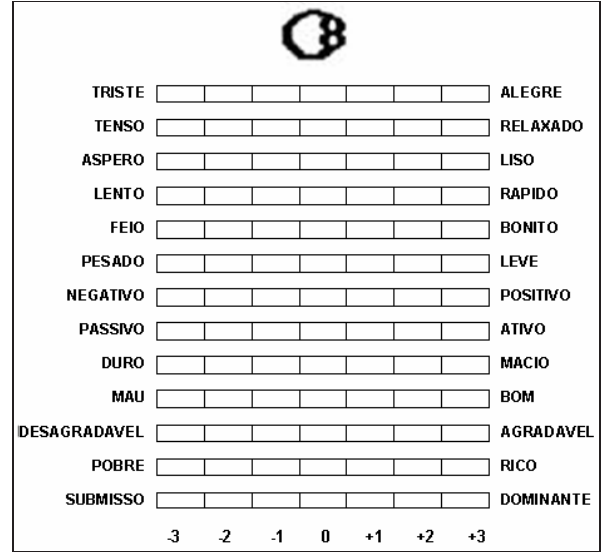
Figura 3. Exemplo de estímulo abstrato e escalas utilizadas pelos participantes nas avaliações